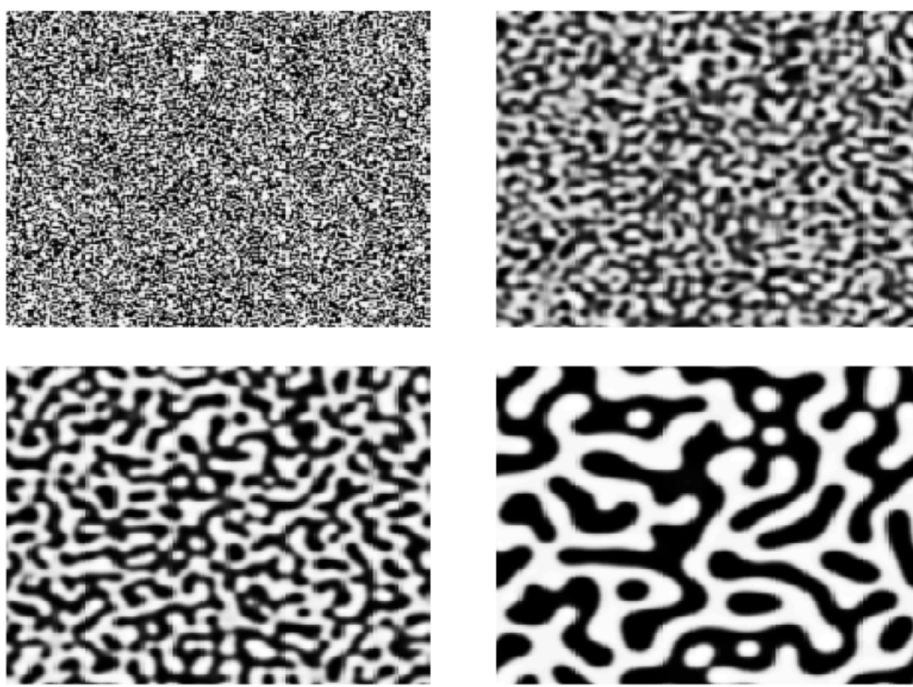
Figure 1. Schematic evolution of spinodal decomposition during time, adapted from [15].